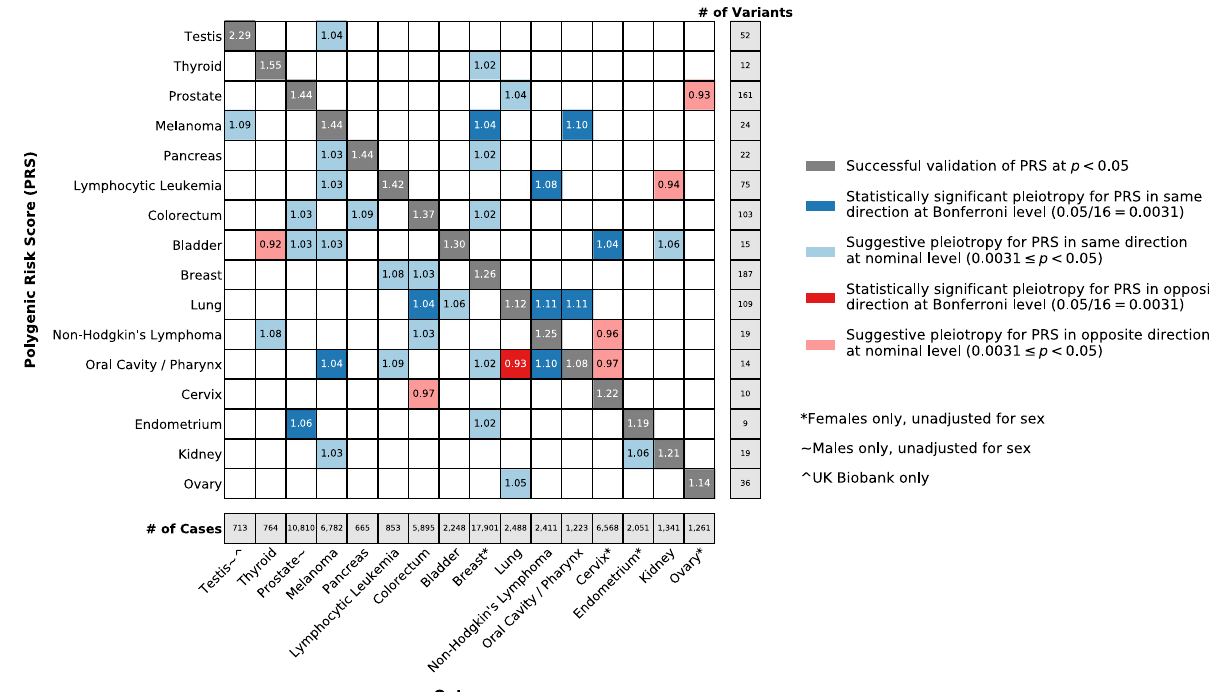
Fig. 1 Odds ratios for at least nominally signi fi cant associations between cancer-speci fi c polygenic risk scores (PRS) and cancer outcomes, based on meta-analyses of European ancestry participants from the Genetic Epidemiology Research on Adult Health and Aging (GERA) cohort and UK Biobank. Odds ratios were estimated from logistic regression models, p values were calculated from two-sided Wald tests, and statistical signi fi cance ( p < 0.05/16 = 0.0031) was determined accounting for multiple testing. Cancers are ordered based on hierarchical clustering of the odds ratios for each PRS across cancer